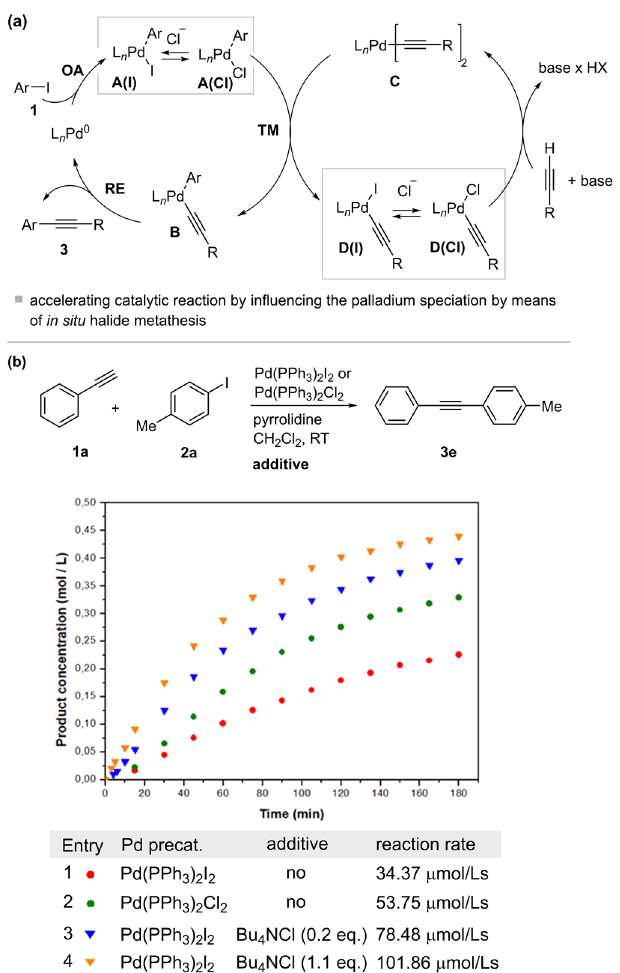
Fig. 10 Accelerating catalytic reaction by in situ halide